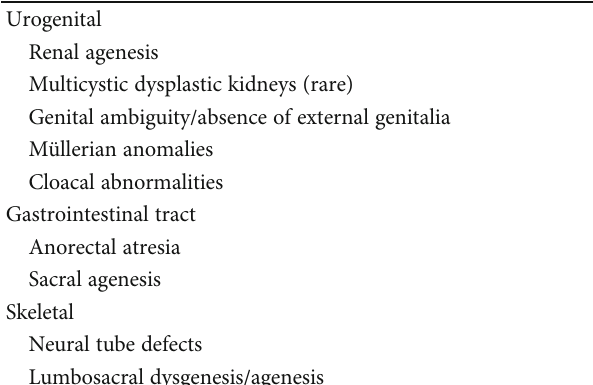
Table 1: Possible associated abnormalities with sirenomelia.